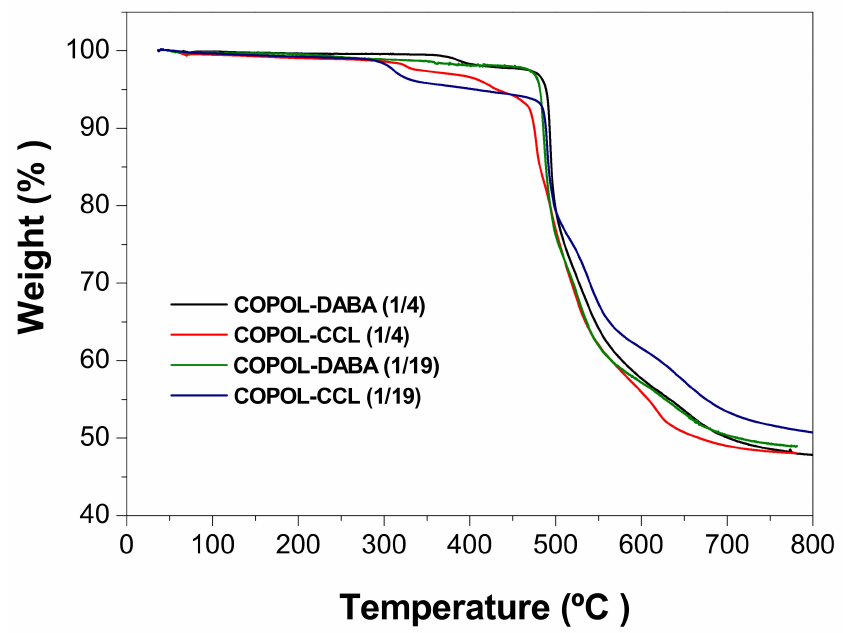
Figure 11. Thermograms of copolyimides and their crosslinked